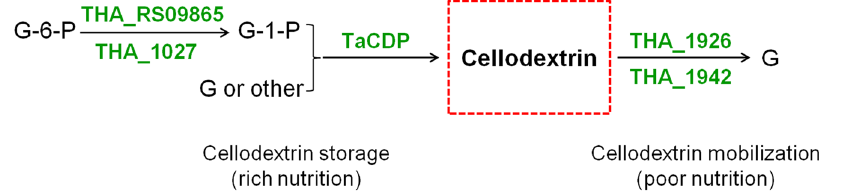
Figure 7. Presumed carbohydrate metabolism pathway with TaCDP involved in Thermosipho africanus